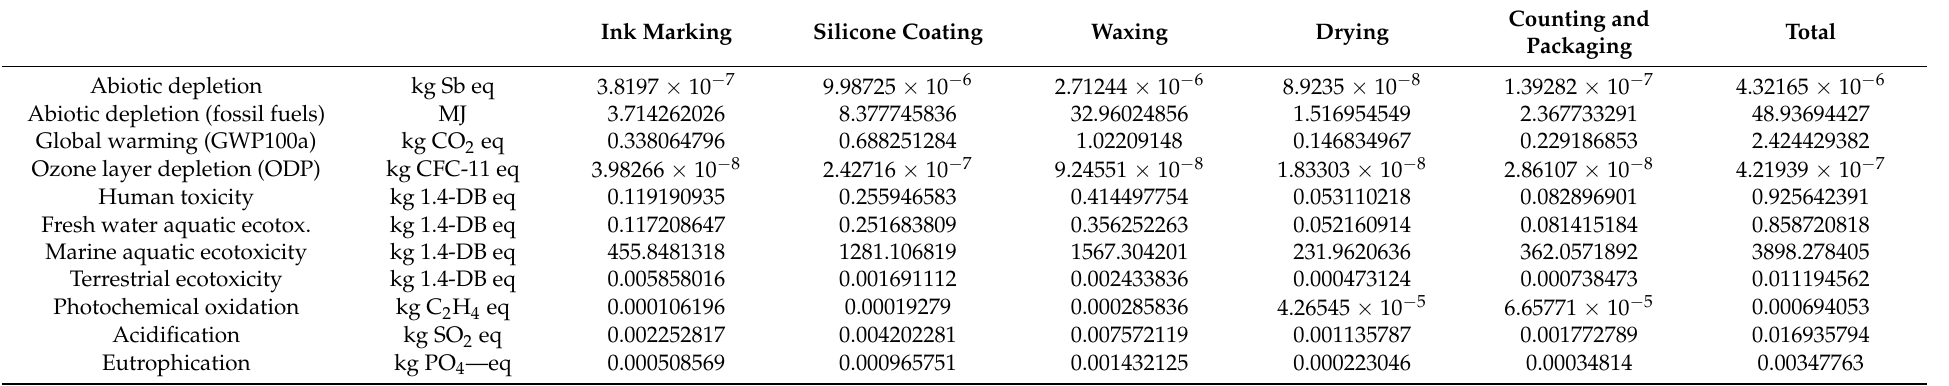
Counting and Packaging